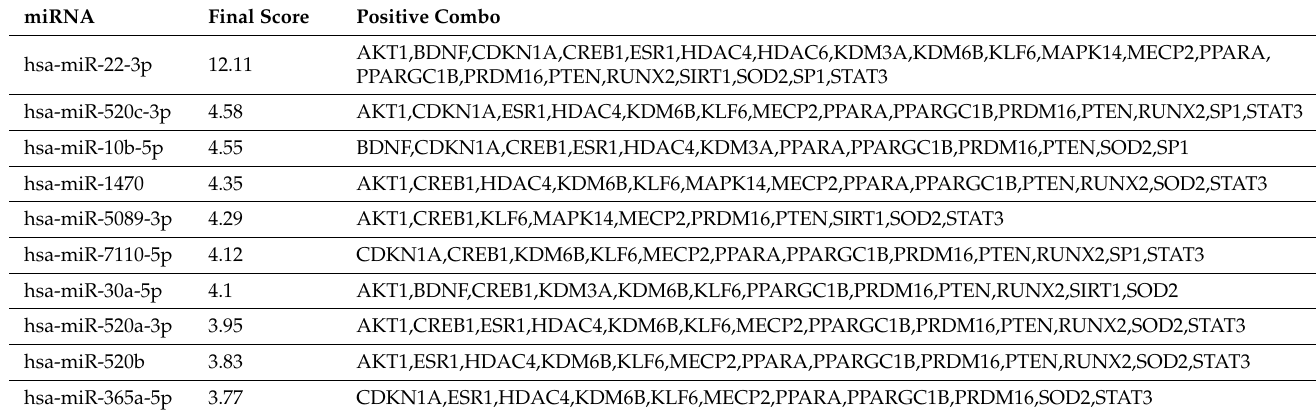
Table 1. Prediction and ranking of interactions between various miRNAs and clusters of metabolic genes in humans using the metaMIR Tool (http://rna.informatik.uni-freiburg.de/metaMIR/Input.jsp (accessed on 3 July 2021)).